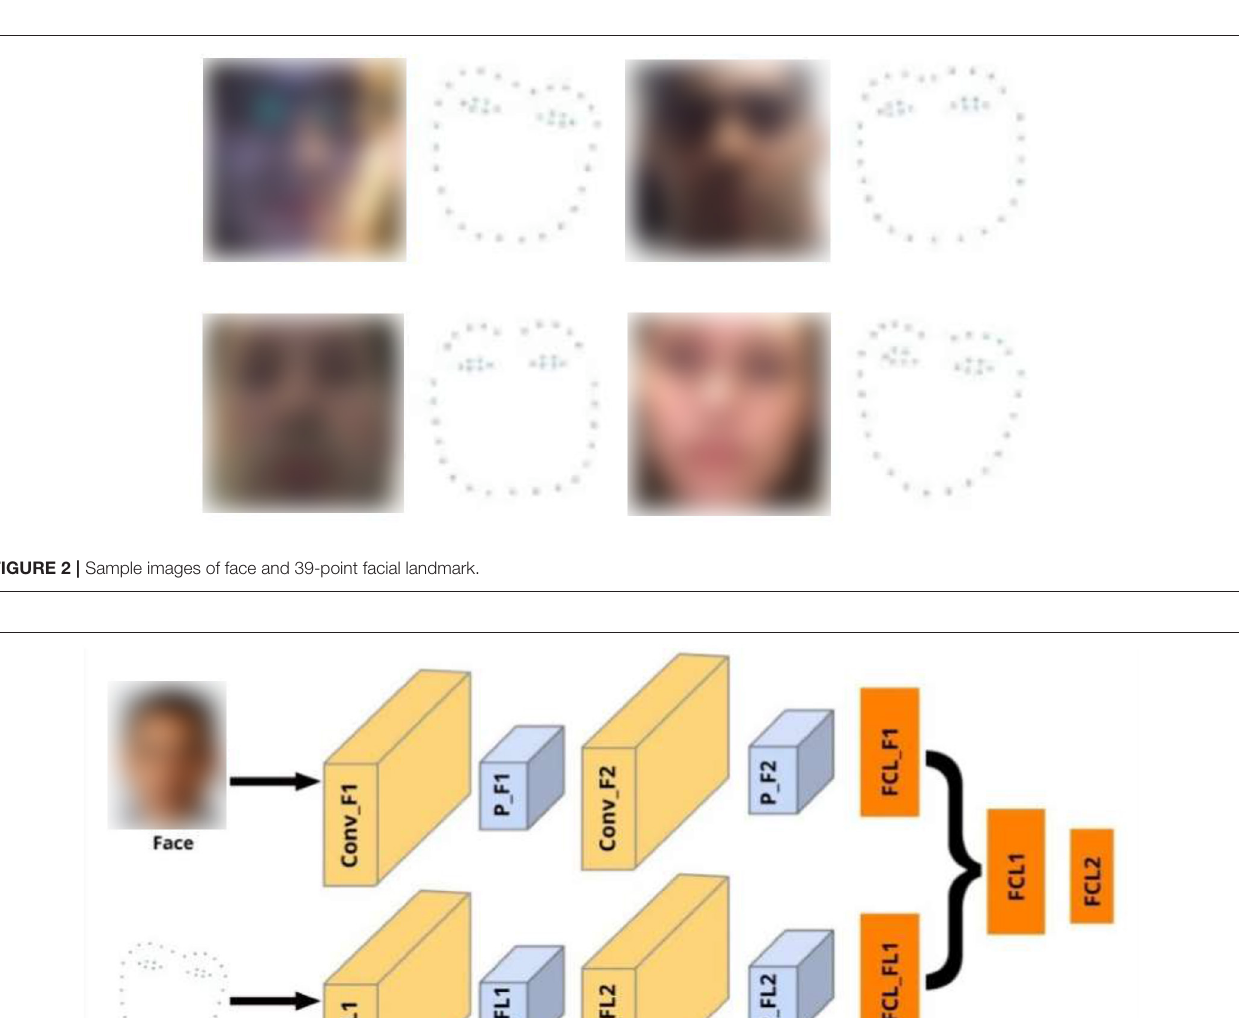
Frontiers in Artificial Intelligence |